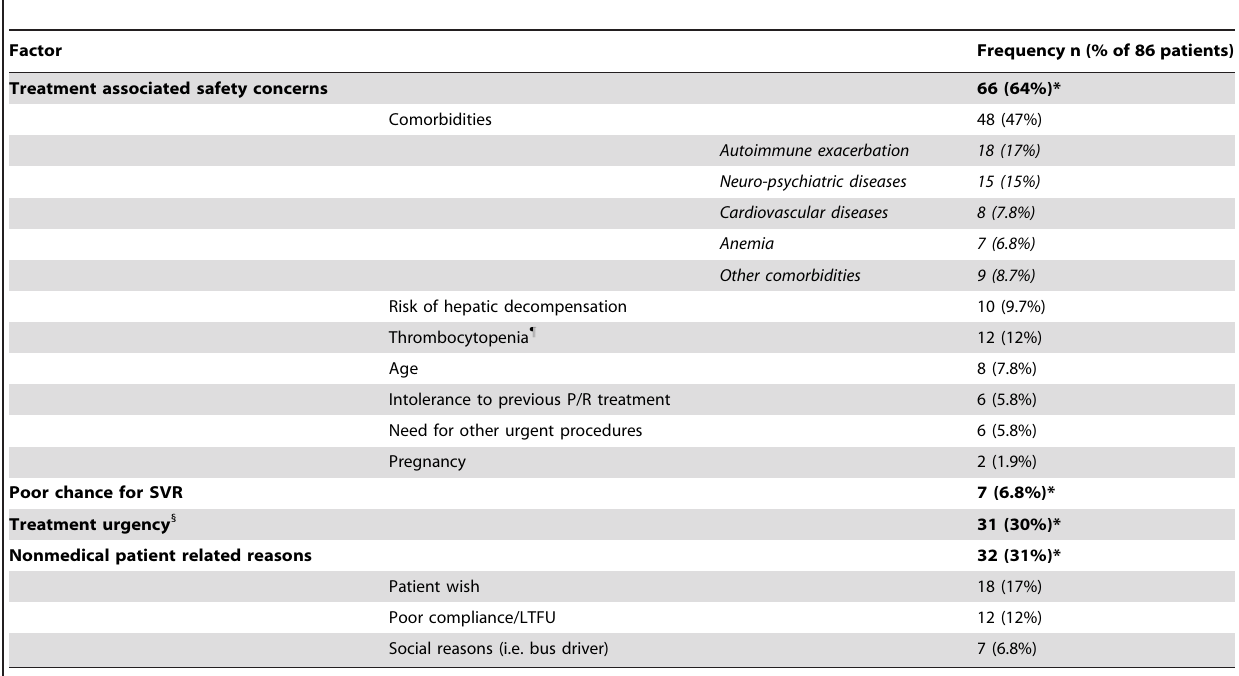
Table 2. Factors that influenced the decision not to treat with P/R/PI.